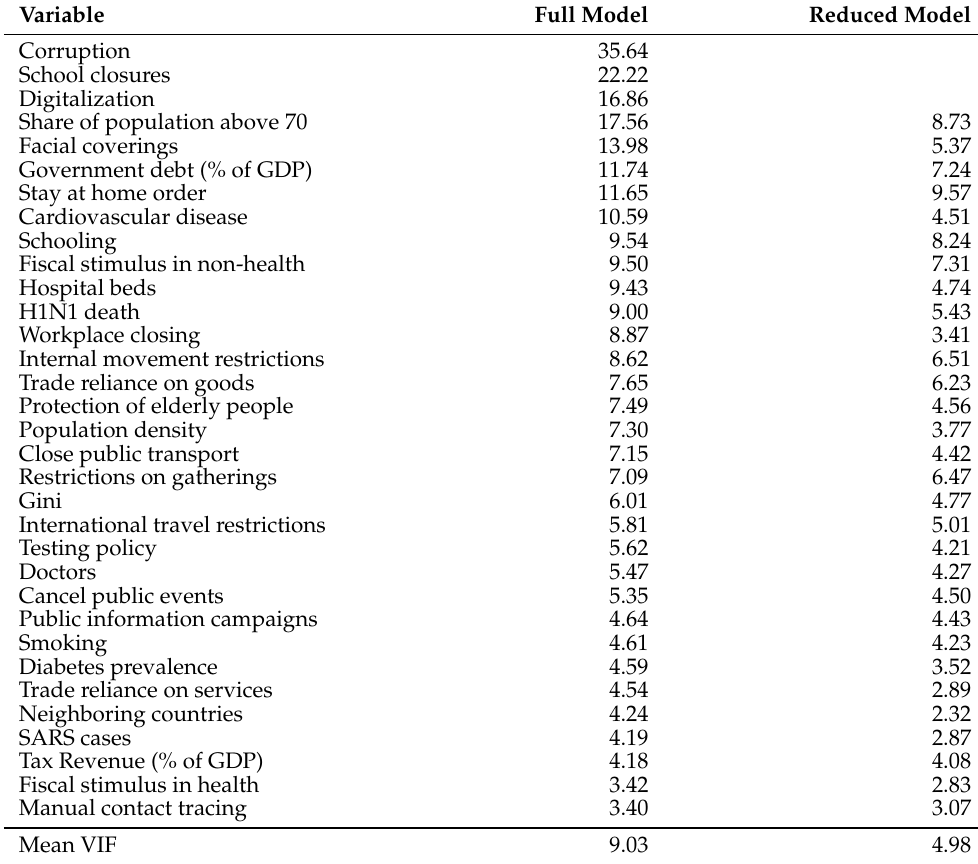
Table A3. VIF for variables in the